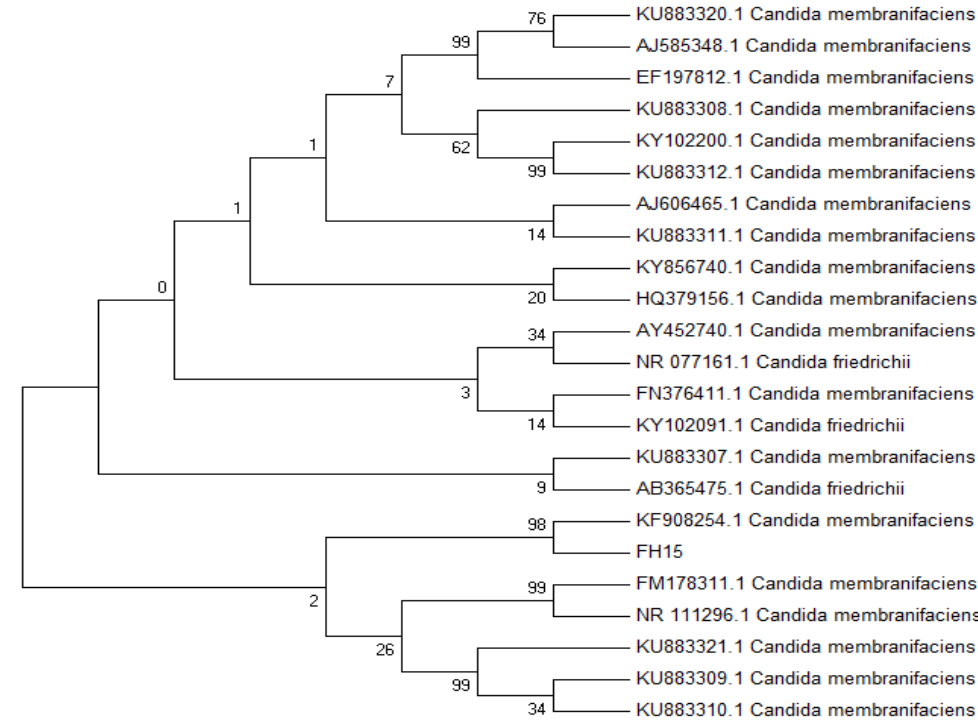
Figure 1. Molecular identification of the FH15. The analysis included 21 nucleotide sequences using the Neighbor joining tree method according to the model from Tamura. Evolutionary analysis has been carried out in MEGA-7. Our new fungal strain C. membranifaciens strongly recommended as a new strain, the 98% bootstrap support for C. membranifaciens isolate FH15.